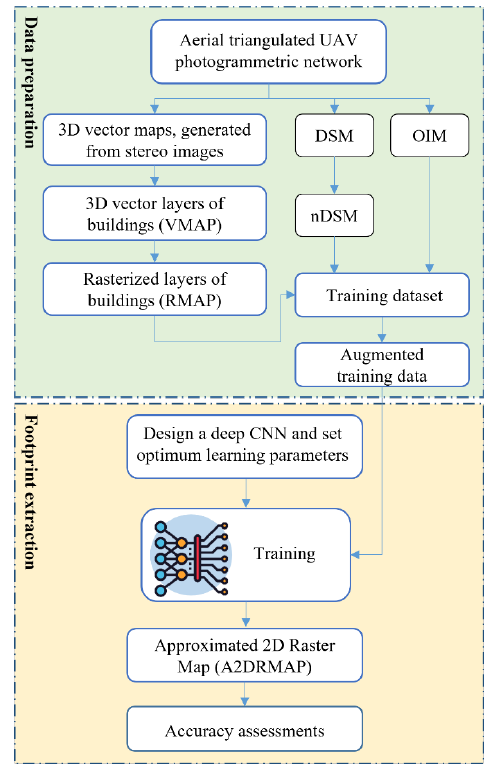
Figure 1 . The proposed